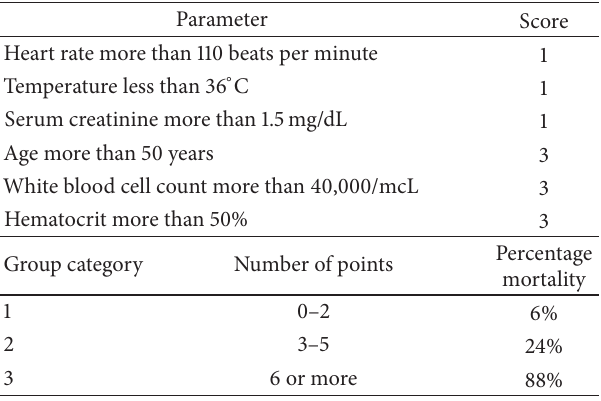
Table 3: Clinical score predictive of death for patients with necro- tizing soft tissue infections